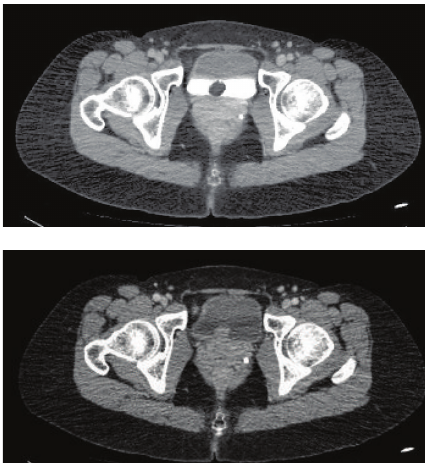
Figure 2: Computed tomography with intravenous contrast, show- ing a contrast captating solid vesical lesion.